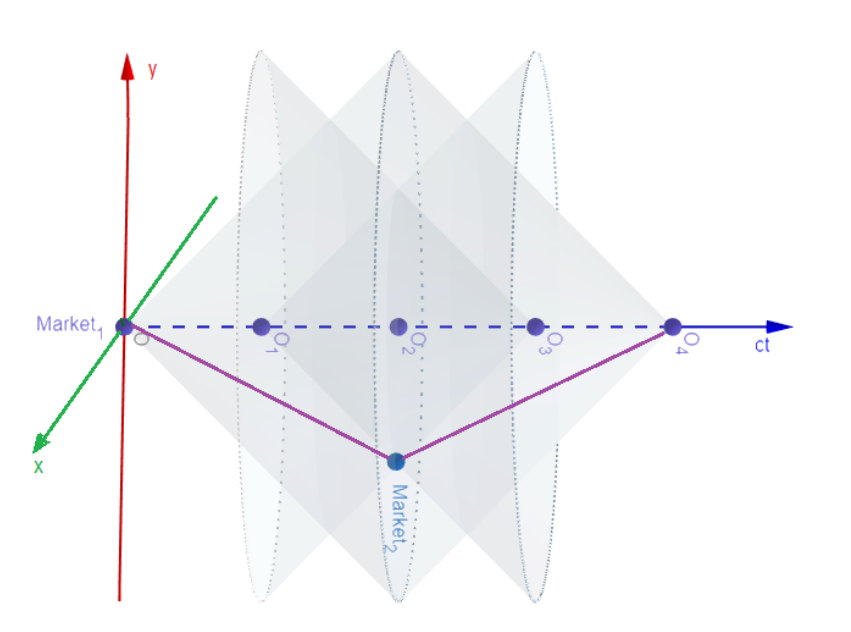
Figure 3. The two market participant case in a spacetime